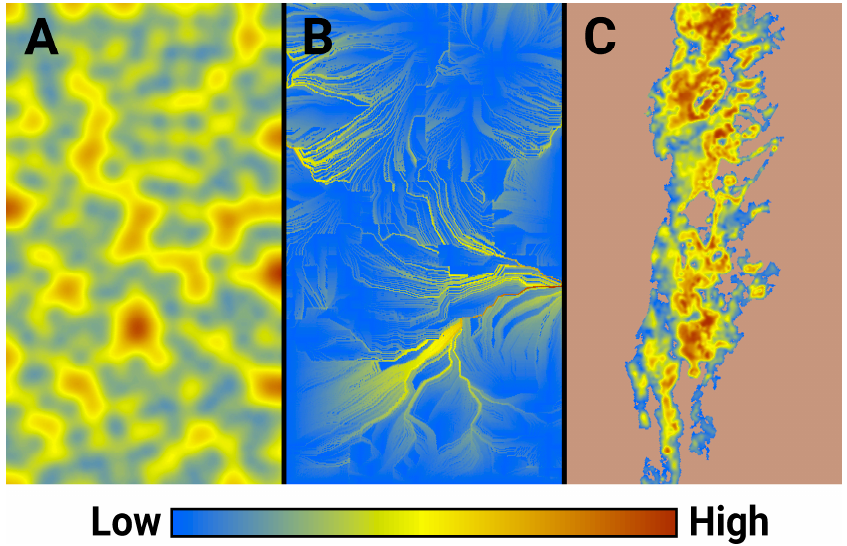
Figure 4. Example 3 spatial inputs, including ( A ) relative flammability, ( B ) wind gradient, and ( C ) marten habitat quality.